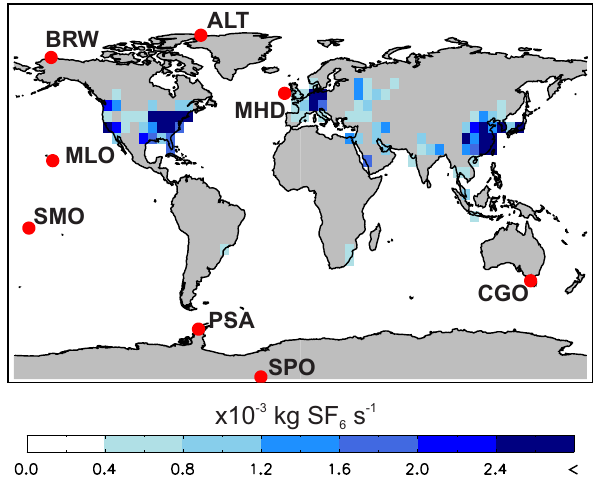
Fig. 1. Emissions of SF 6 ( × 10 − 3 kggridcell − 1 s − 1 ) on the 5 . 6 ◦ × 5 . 6 ◦ TOMCAT grid forthe year2008. Figure 1. Emissions of SF 6 ( × 10 − 3 kggridcell − 1 s − 1 ) on the Locations of NOAA surface stations used in this study are also shown. 5 . 6 ◦ × 5 . 6 ◦ TOMCAT grid for the year 2008. Locations of NOAA surface stations used in this study are also shown. 35